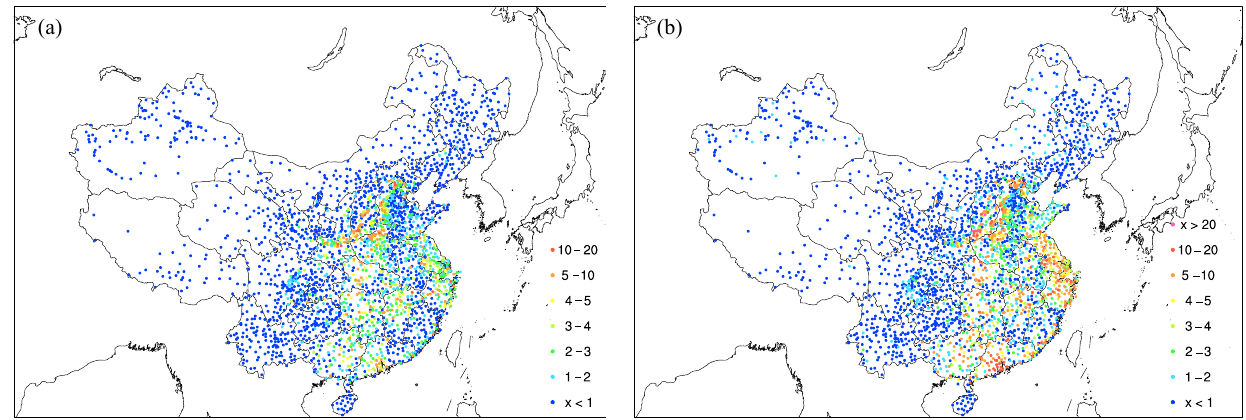
Figure 2. The winter-average monthly haze days (units: daysmonth − 1 ) during years (a) 1960–2013 and (b) 2000–2013 over mainland China.